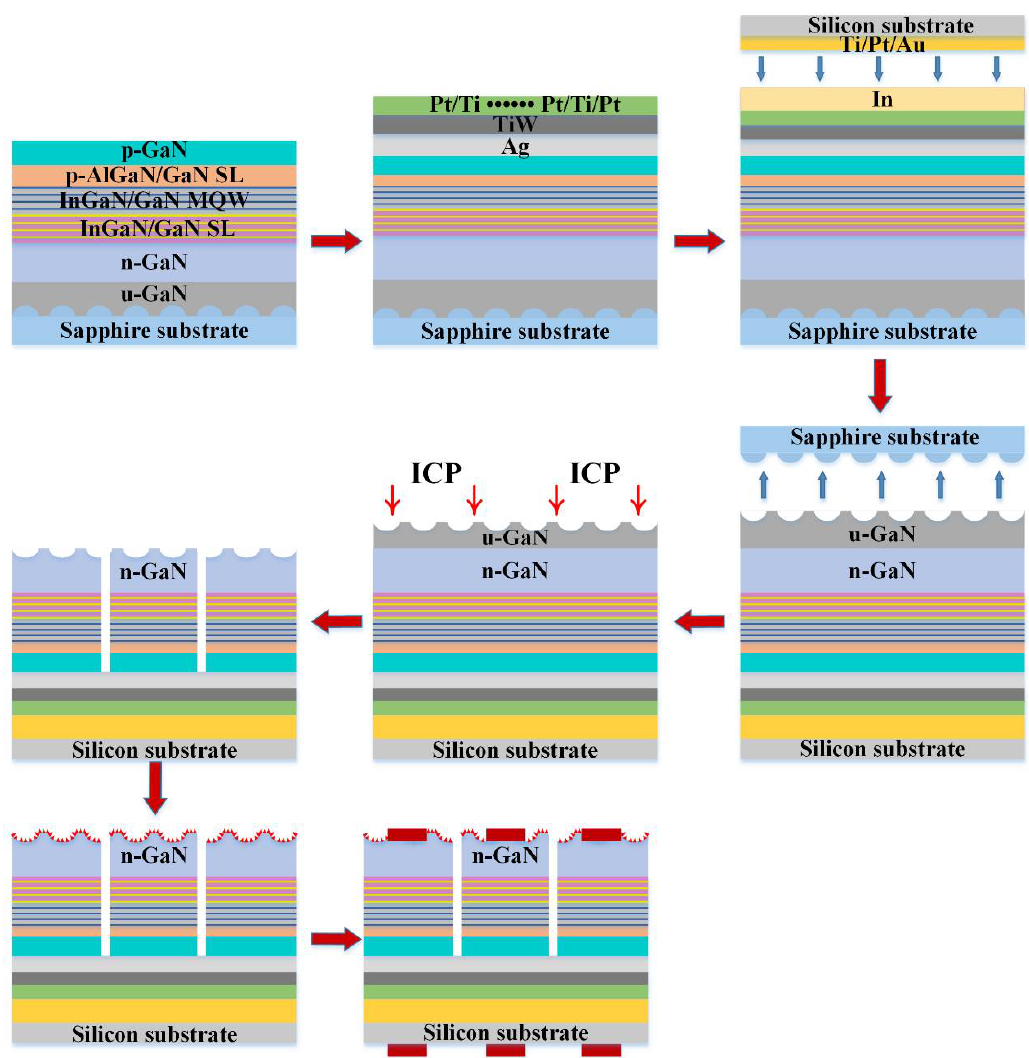
Figure 1. Schematic illustration of the fabrication process of vertical LEDs.